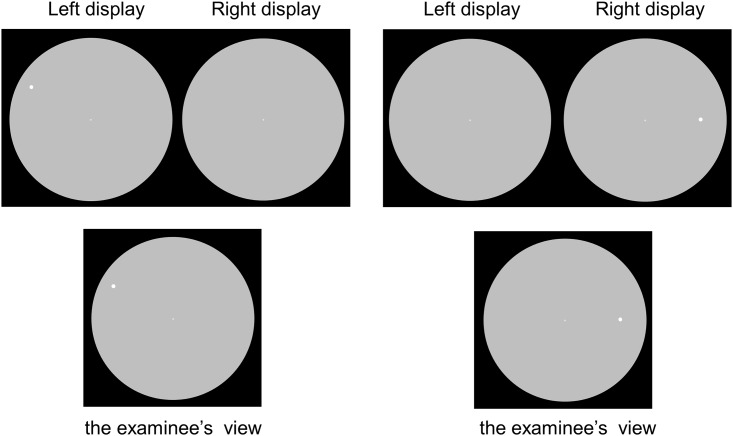
Target presentation and the examinee’s view during the binocular random single eye test.The test target was presented randomly to either eye under a non-occlusion condition and the patient was not aware of which eye was being tested. To better demonstrate this test with visible targets, target size V is used in this figure although target size III was the actual size used in this study.